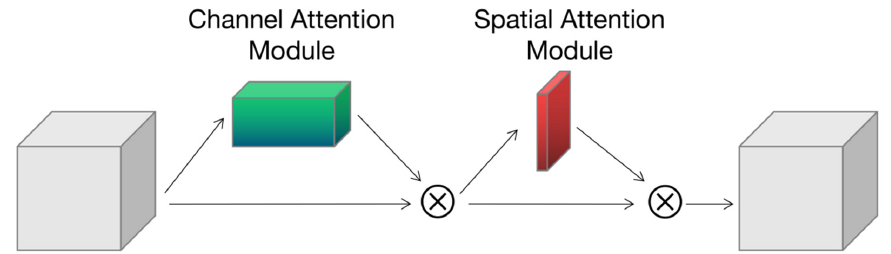
Figure 10. Convolutional block attention module structure.